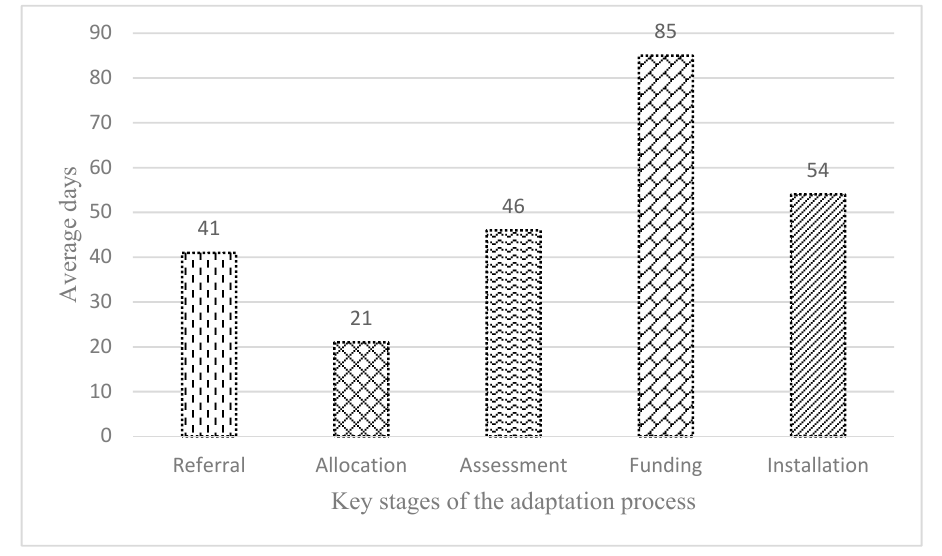
Figure 3. Average waiting time for each stage in the adaptation process.